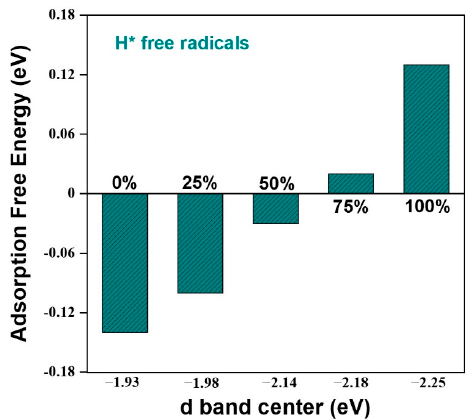
Figure 5. The adsorption free energy values of hydrogen atoms on different d-band central atoms.